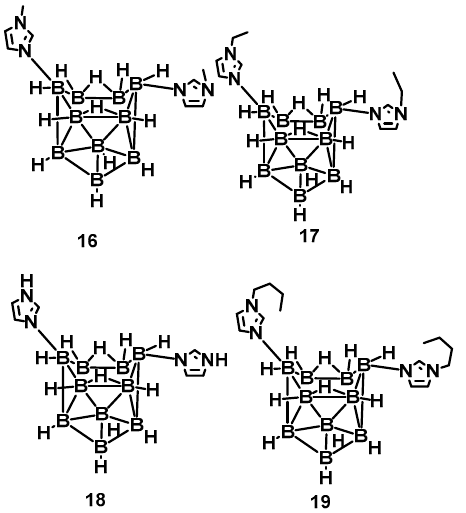
Figure 3. The structure of N -alkyl imidazole-B 10 H 12 and imidazole-B 10 H 12 complexes [20].